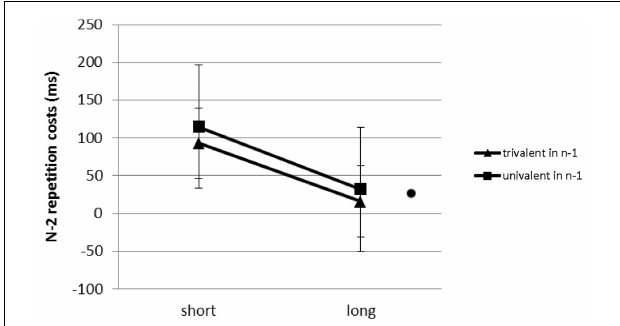
FIGURE 2 | n − 2 Repetition cost as a function of stimulus valence in trial n − 1 and CTI for Experiment 2. Error bars denote 95% within-subject confidence